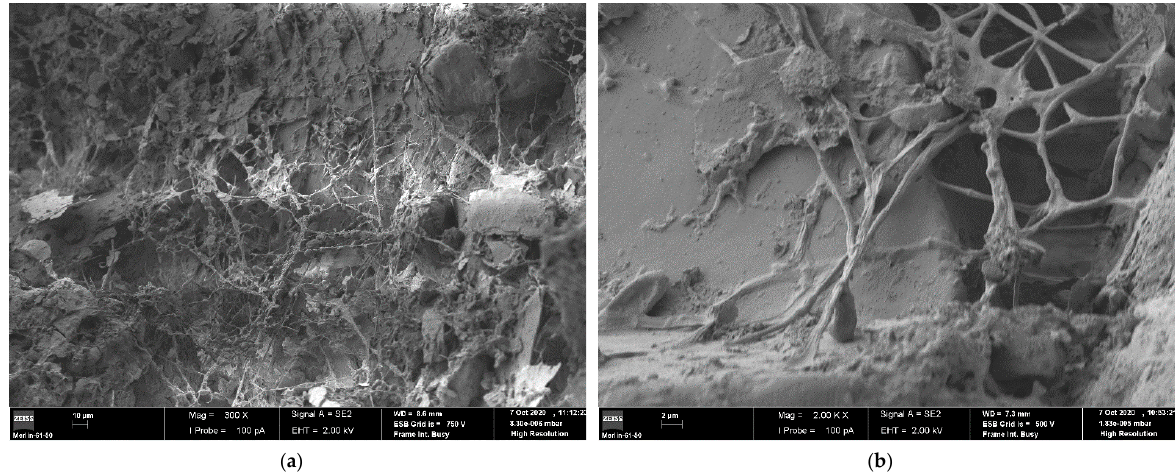
Figure 7. ( a ) SEM image of the mixture Lab XG-soil at 300×. ( b ) Scale-up of Figure 7a to 2.000×.